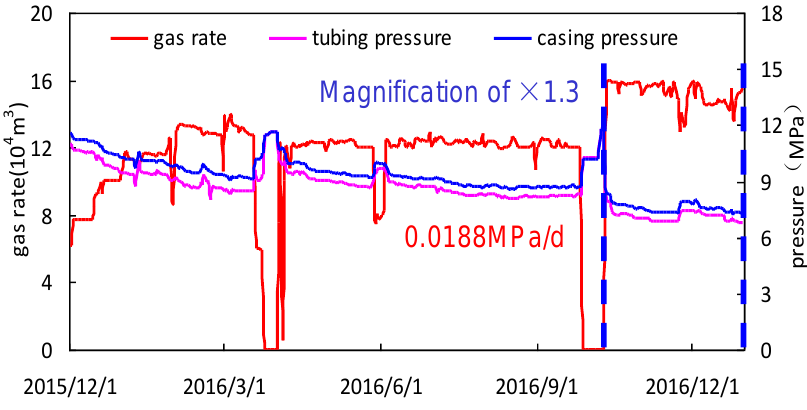
Figure 7—Well X-1 production history